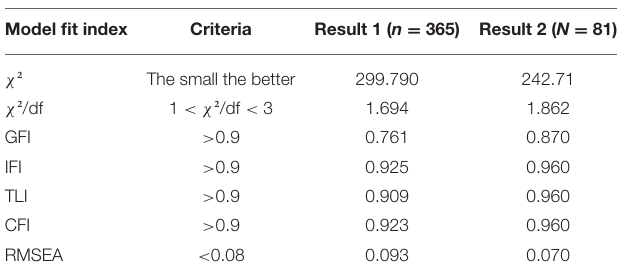
TABLE 7 | Model fit.